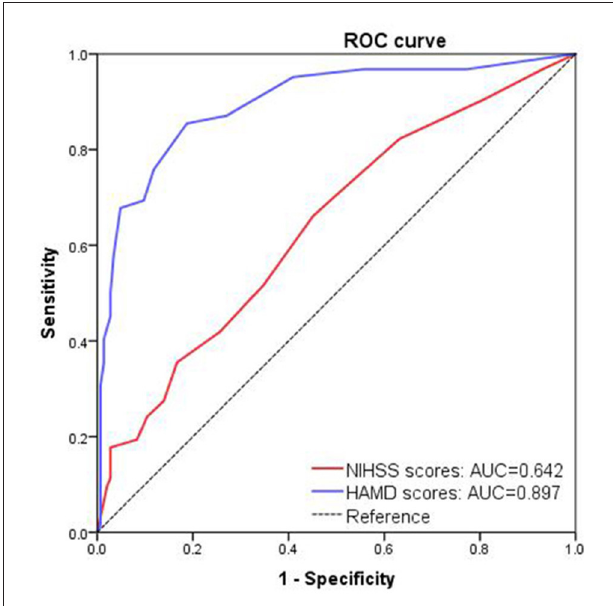
FIGURE 3 | Receiver operating characteristic (ROC) curve analysis of National Institutes of Health Stroke Scale (NIHSS) scores and Hamilton Depression Scales (HAMD) to indicate post-stroke